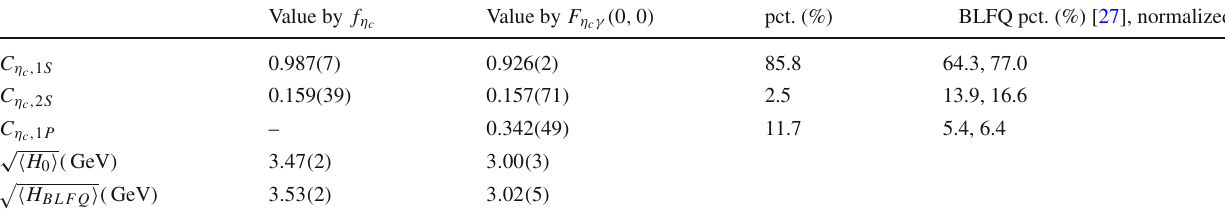
( 0 , 0 ) according to Eqs. (41) Table4 Thewavefunctionof η c definedinEq.(50).Thevaluesofbasis width via the transition form factor F η c γ coefficients are obtained by fitting the diphoton decay width (cid:14) η and (42). The corresponding LFWF is what we provide from this work. to c → γγ The percentage of each basis state is calculated by taking the square the PDG value (see Table 3) at κ = ˆ κ, m f = ˆ m f . Uncertainties come of the corresponding basis coefficient. The BLFQ values are extracted from those of the parameters and the PDG decay width. In the second from the LFWF that is solved from the Hamiltonian formalism [27]. column,thevaluesofbasiscoefficientsareobtainedbyfittingthedipho- The meson mass is estimated by evaluating the expectation value of H ton decay width via the decay constant formula according to Eq. (47). according to Eq. (27) There, the LF-1P component is taken away. In the third column, the values of basis coefficients are obtained by fitting the diphoton decay ( 0 , 0 ) Value by f η Value by F η c c γ